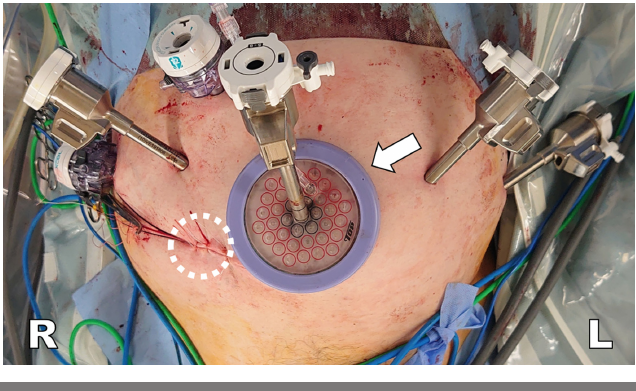
Figure 3. The harvested ileum was repositioned into the abdominal cavity, and the wound at the stoma site was closed with a silk suture (circle with white broken lines). The Smart Retractor® was covered with Free Access® (white arrow), and the abdominal cavity was reinsufflated.